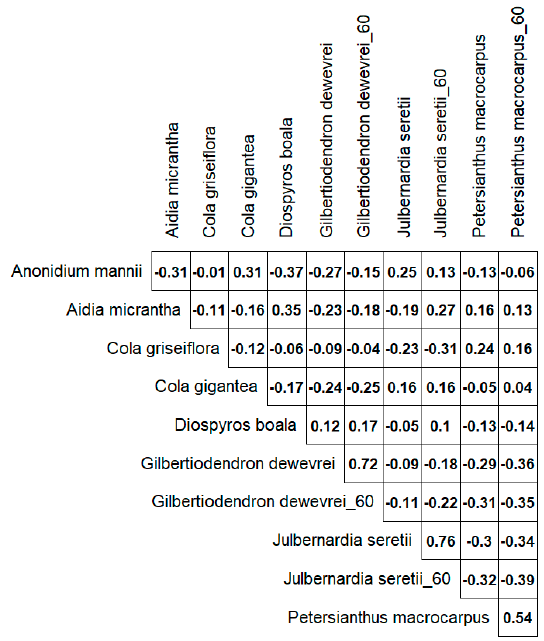
Figure 5. Correlation matrix for size classes (cutoff at 60 cm diameter at breast height (DBH)) of the main dominant species. Cutoffs for diameter class are either < 60 cm (species name only) or > 60 cm (species name_60; where tree size exists).